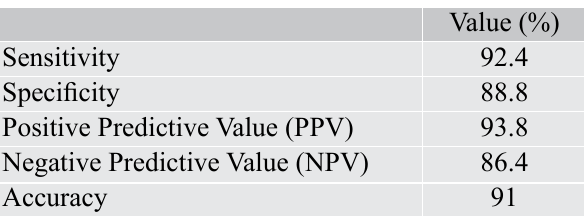
Table IV: Distribution of subjects according